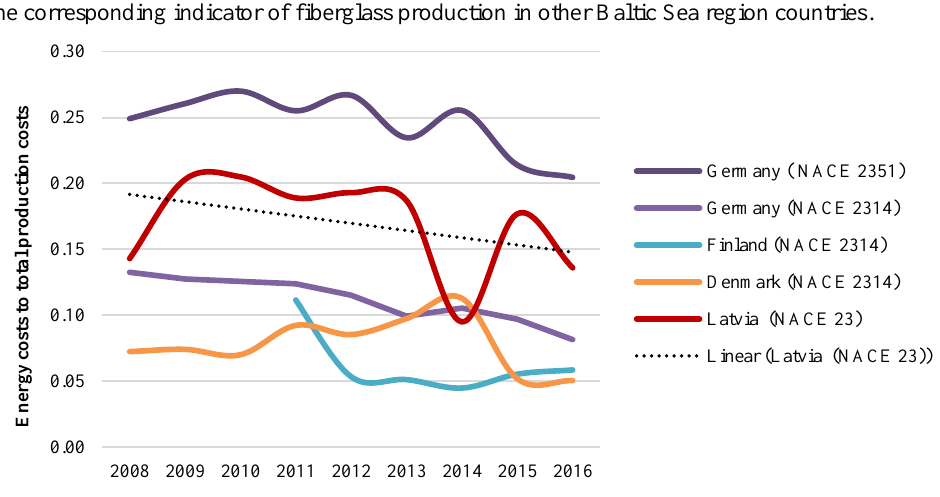
Fig. 8. Energy costs to total production costs in non-metallic minerals producing industries in Latvia (NACE 23), manufacture of cement in Germany (NACE 2351) and manufacture of fibre glass (NACE 2314) in Baltic Sea region